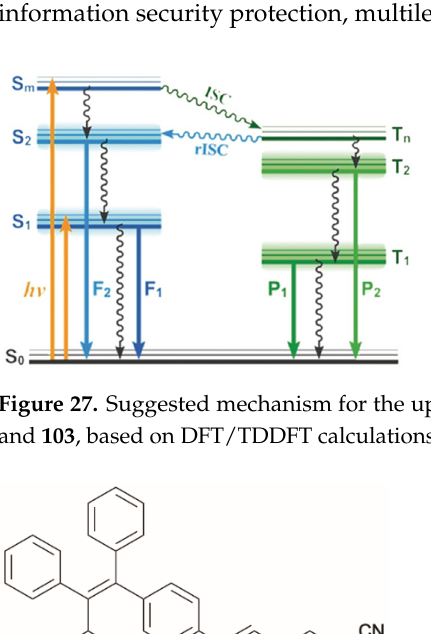
Figure 26. Possible mechanism for the dual TADF proposed for 100 on the basis of TDDFT calcula- tions (SOCME represents spin-orbit coupling matrix element). Adapted with permission from [84].